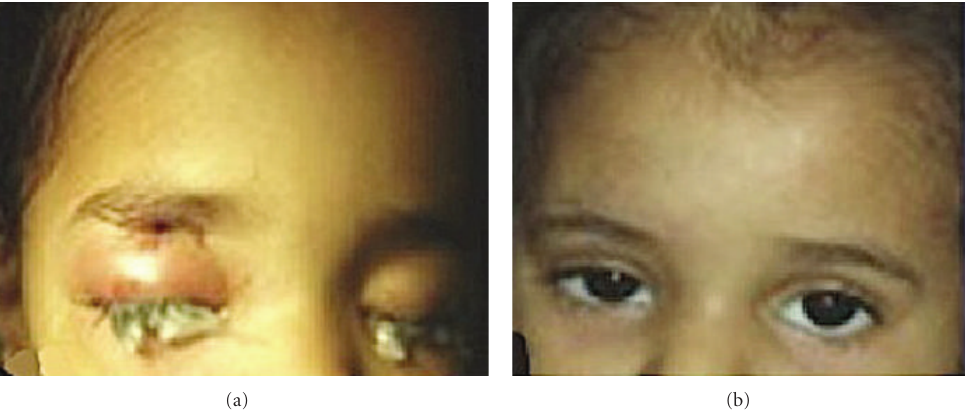
Figure 2: Photographs of the patient, showing right periorbital swelling before treatment (a) and the resolution of swelling with residual mild right-eye ptosis